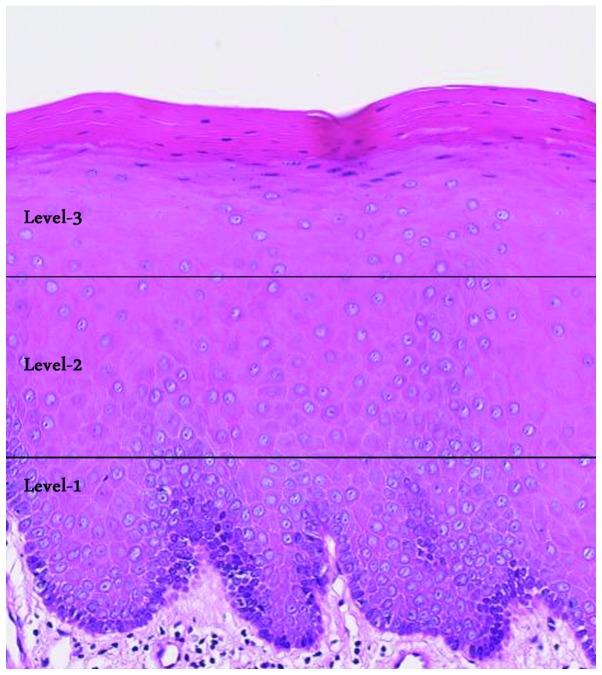
Imaginary division of an oral epithelium. The oral epithelium was divided into three levels to evaluate the distribution of the immunostained-positive cells. The lower one-third, lower two-thirds and upper one-third of the epithelium were designated as levels 1, 2 and 3, respectively.